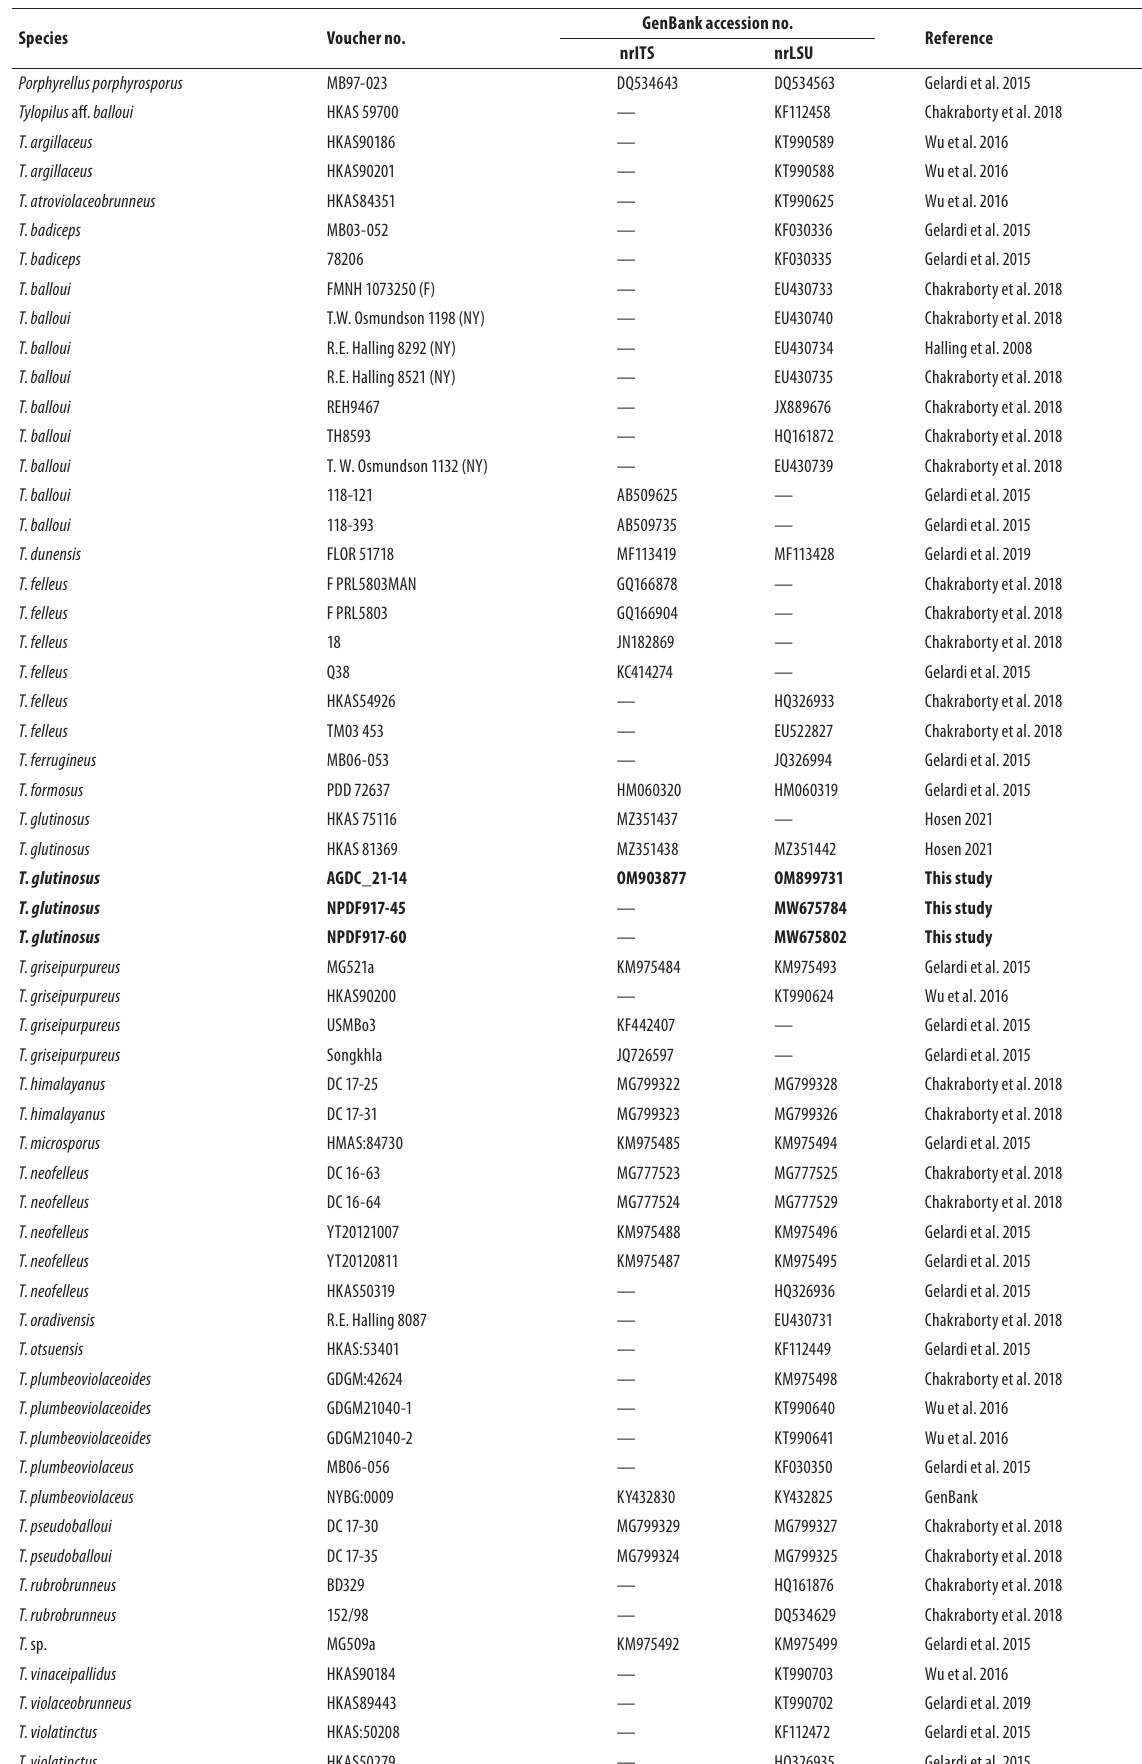
Table 1. A list of species, voucher no., GenBank accession no. and reference of species used in this study.